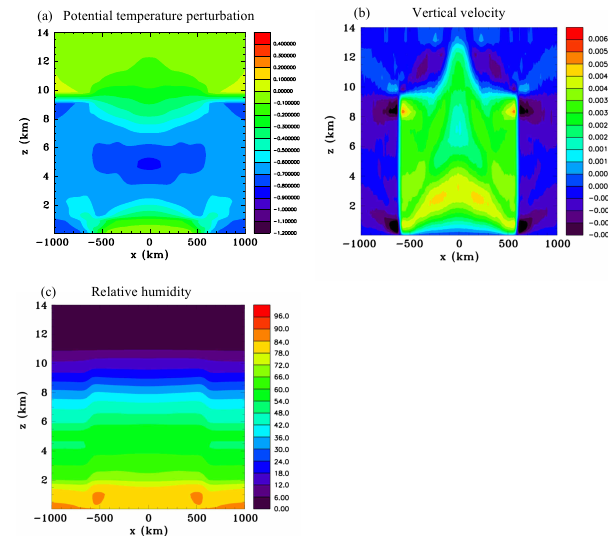
Figure 6. Vertical sections for Experiment 5: the large annulus case, at t = 12h. (a) Potential temperature perturbation (K), (b) vertical velocity (ms − 1 ), (c) relative humidity, and (d) y -component of ve- locity, v (ms − 1 ).